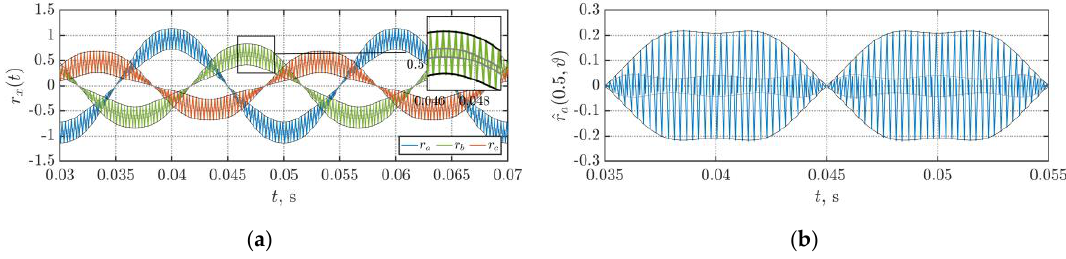
Figure 8. Primary (black) and secondary (gray) envelopes in case of THIPWM1/6 at m = 0.5 and f sw =